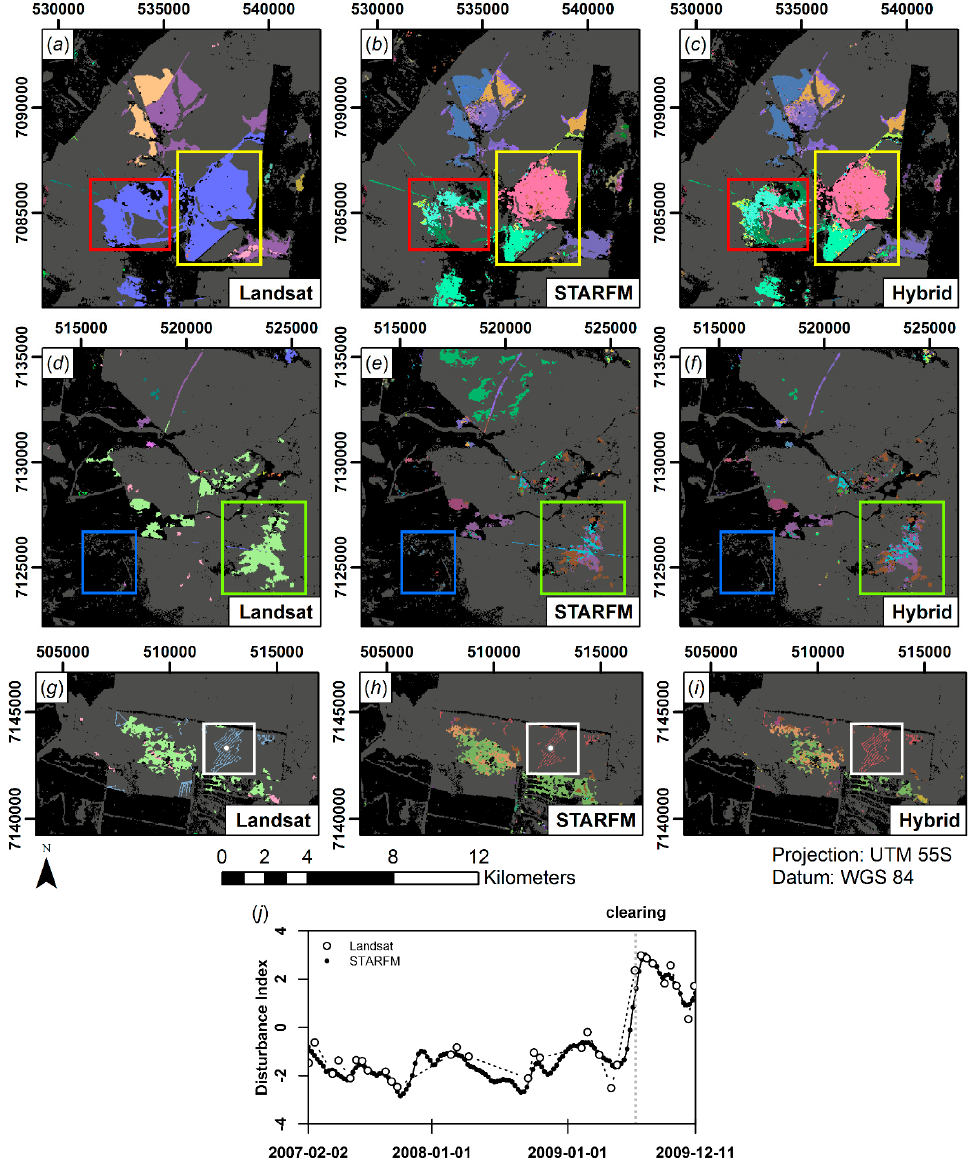
Figure 10. Disturbance detection for the previously introduced subsets; see Figure 7 for ( a – c ), Figure 8 for ( d – f ), Figure 9 for ( g – i ). The Landsat detection, STARFM detection, and hybrid detection is shown in columns 1–3, respectively. See Figure A1 for the Landsat random color map and Figure A2 for the STARFM and hybrid random color map. ( j ) Temporal profiles of the Disturbance Index for the pixel marked in ( g , h ).